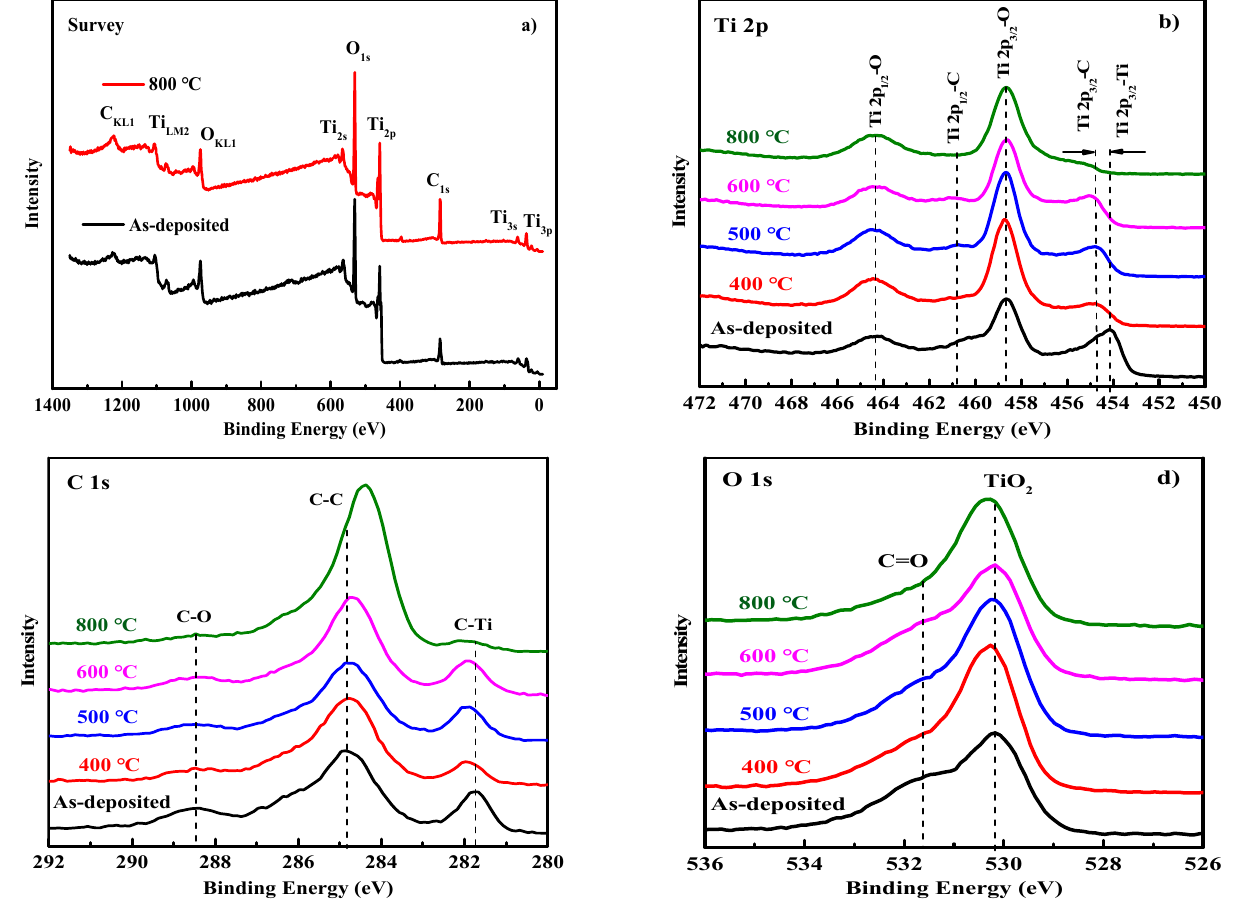
Figure 3. XPS spectra for ( a ) survey, ( b ) Ti 2p, ( c ) C 1s and ( d ) O 1s of as-deposited and annealed TiC thin films with a thickness of 610 nm. Table 1. XPS and EDS analysis of atomic content of TiC thin films with annealing temperature. Composition by XPS (at.%) Composition by EDS Samples